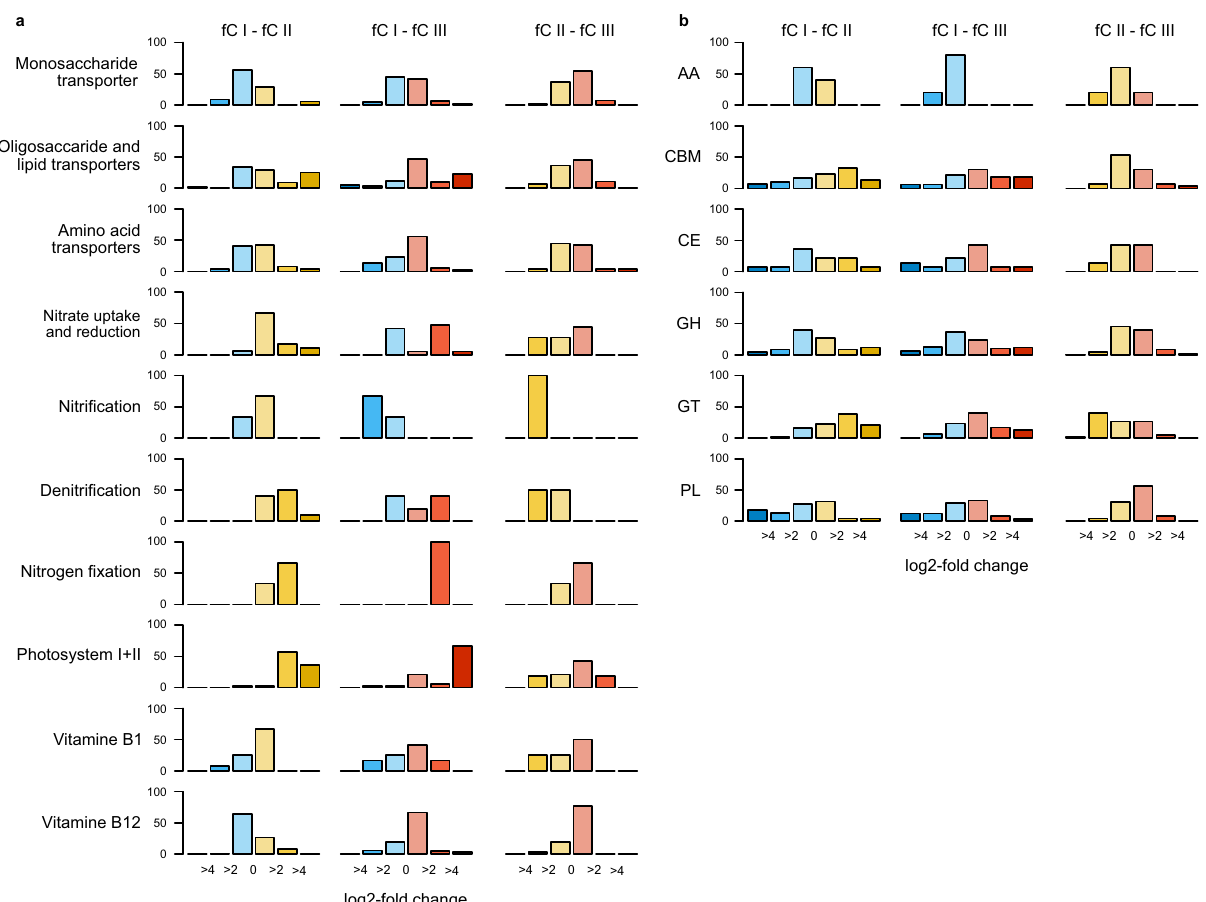
Fig. 3 Differential KO abundance between functional clusters (fC) of the AOM. a Proportion of pairwise differential KO abundance of selected pathways and functional groups between fC I (blue), fC II (yellow), and fC III (red) determined by DESeq2. b Pairwise differential CAZyme abundance between the fC I – III as in a (for abbreviations see legend of Fig. 4). Binned log2-fold change 0 – 2: no or weak difference between clusters, 2 – 4: intermediate enrichment, >4: strong